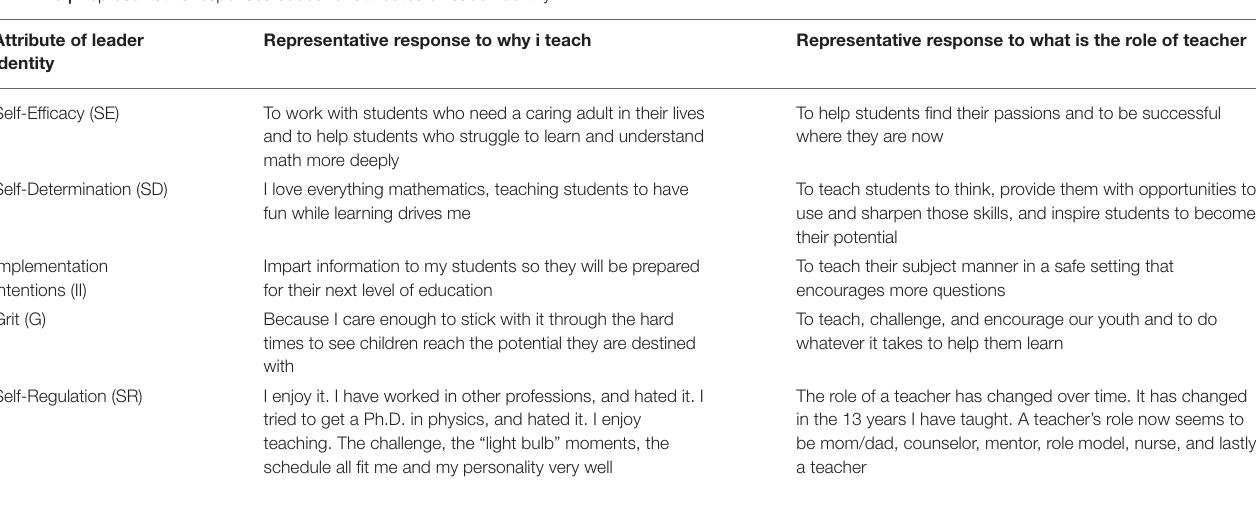
FIGURE 1 | Frequency of attribute expressed in the responses to our two free-response items. TABLE 6 | Representative responses coded for attributes of leader